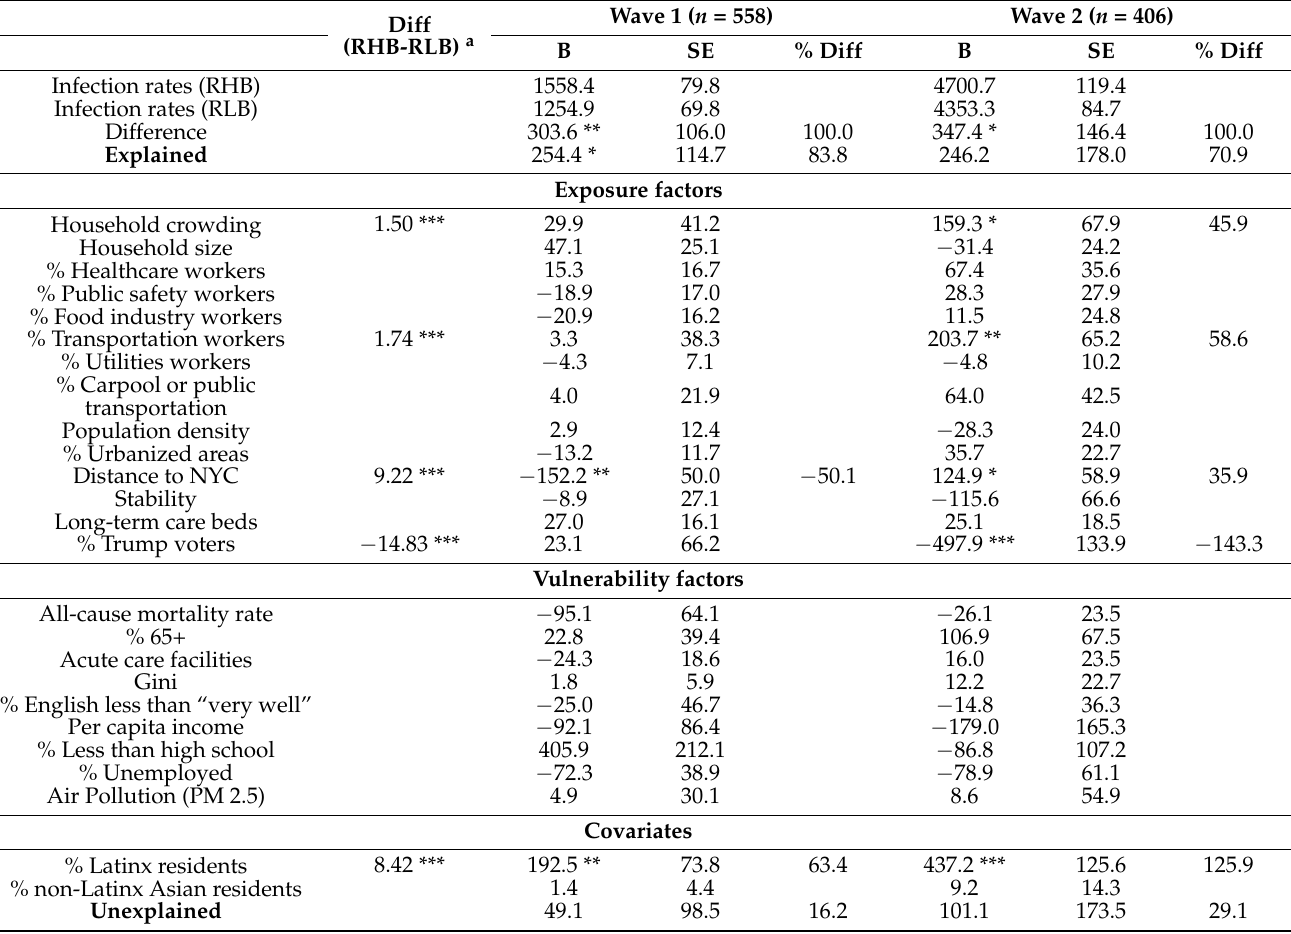
Table 3. Decomposition analysis contrasting RHB to RLB